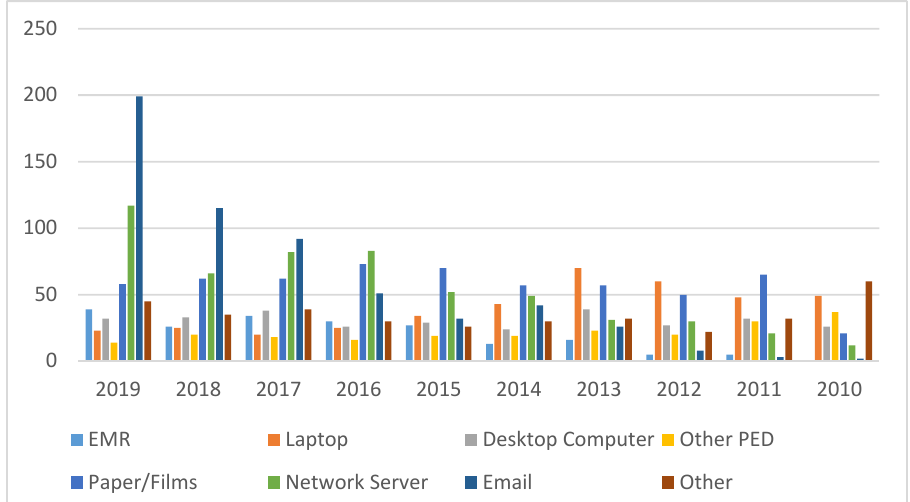
Figure 5. Comparative Graphical Representation.